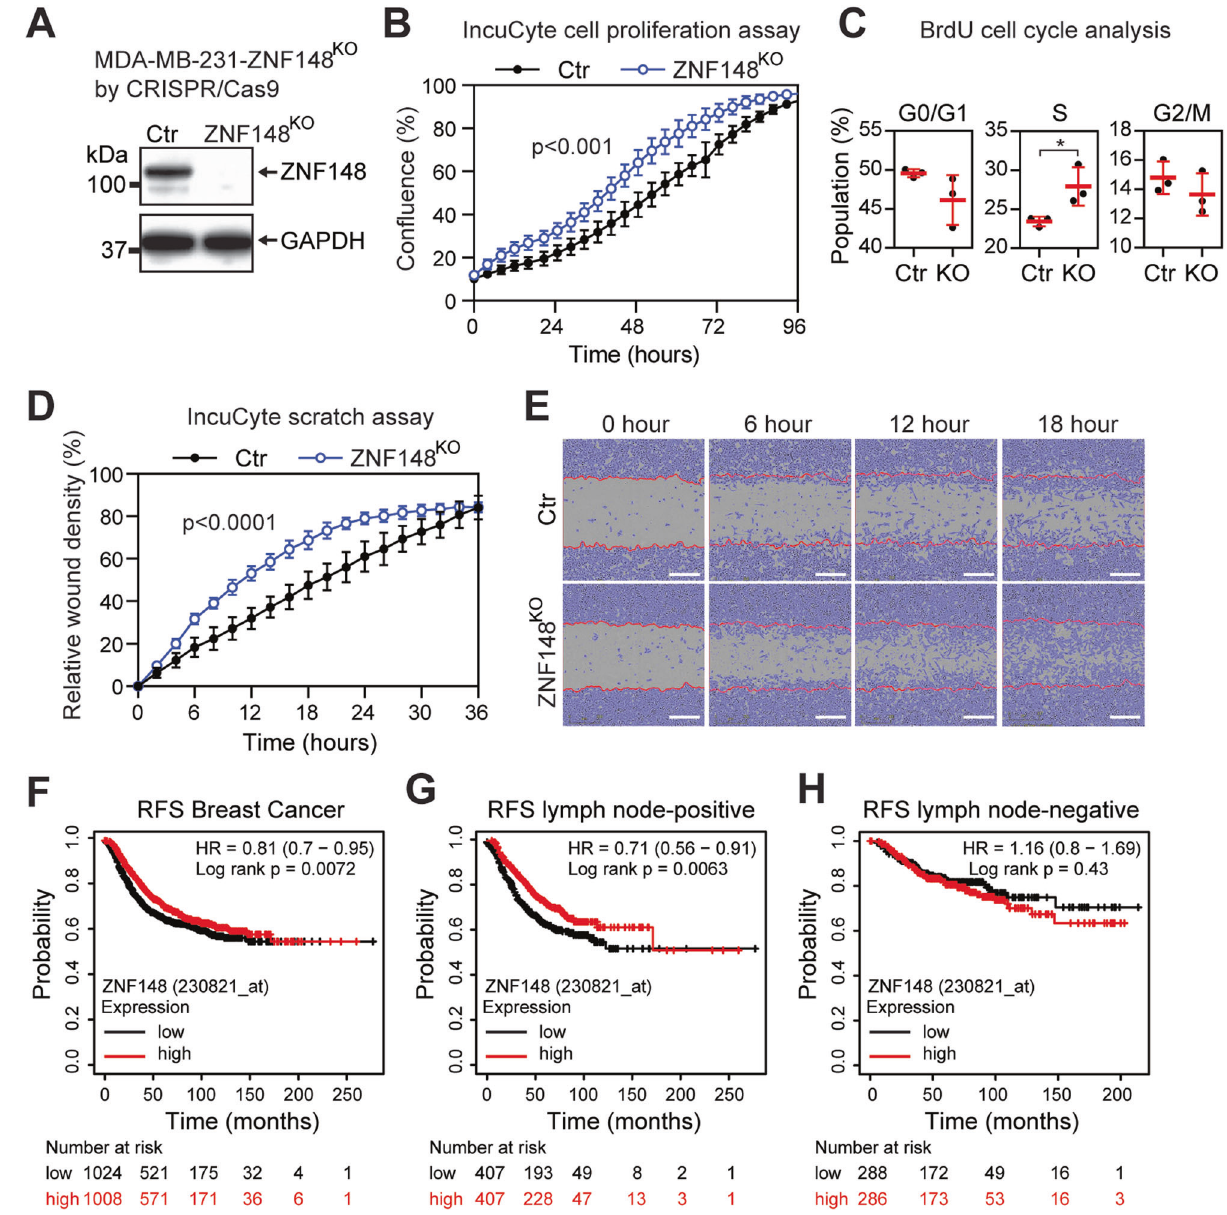
Fig. 3 ZNF148 depletion promotes breast cancer cell growth, migration, and a low-level associate with a worse prognosis. A Western blot analysis of CRISPR/Cas9 ZNF148 knockout (KO) clone, compared to the wild type control (Ctr). B Percentage (%) area con fl uence of cells in “ A ” , measured by IncuCyte ® live-cell imaging over 96 h period (a representative plot from n = 3 biological replicates, each with n = 6 technical replicates, Two-way ANOVA p-value, Error bars represent mean ± SD). C BrdU cell cycle analysis of cells in “ A ” ( n = 3, Error bars = mean ± SD). D IncuCyte ® scratch wound healing assay of cells in “ A ” (a representative plot from n = 3 biological replicates, each with n = 6 technical replicates, Two-way ANOVA p -value, Error bars indicate mean ± SD, Two-way ANOVA p < 0.0001). E Representative photographs of the cells in “ A ” with the cell con fl uent area depicted in purple and the initial scratch front at time 0 depicted as a red line. Scale bars, 300 μ M. F Relapse- free survival analysis of entire breast cancer patients in Kaplan – Meir plotter database [79]. G As in “ F ” for lymph node-positive breast cancer cases. H As “ F ” for lymph node-negative cases. Student ’ s t-test, * P < 0.05. RFS, relapse-free in 78% of the downregulated genes, indicating that these genes potential clonal biases and allow the detection of immediate gene are positively regulated by ZNF148. Similarly, 59% of the genes expression changes, RNA-seq was performed on total RNA isolated upregulated in MDA-MB-231-shZNF148 were the direct binding from early passage MDA-MB-231-shCtr and MDA-MB-231- targets of ZNF148, identifying these as negatively regulated by shZNF148 cells. These analyses revealed 229 signi fi cantly upregu- ZNF148 (Fig. 5B). The plot of cumulative fraction of genes (%) lated genes (Padj < 0.05, Fold change > 1.5) and 298 down- versus rank of genes based on regulatory potential score (from regulated genes (Padj < 0.05, Fold change < − 1.5) upon the high to low), predicted that ZNF148 functions as both an activator depletion of ZNF148 (Fig. 5A). We identi fi ed additional direct and repressor (Fig. 5C). GO term biological process analysis of the and indirect target genes of ZNF148 by combined analysis of genes that are directly repressed by ZNF148 showed an BioChIP-seq and RNA-seq data. ZNF148 occupancy was identi fi ed